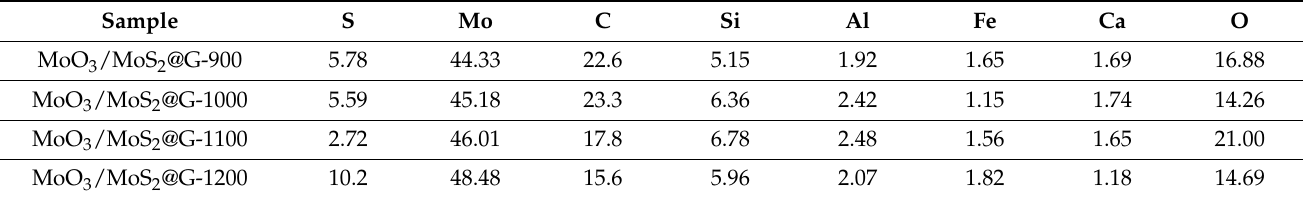
Table 2. XRF quantitative analysis of the MoO 3 /MoS 2 @G samples prepared at various temperatures.